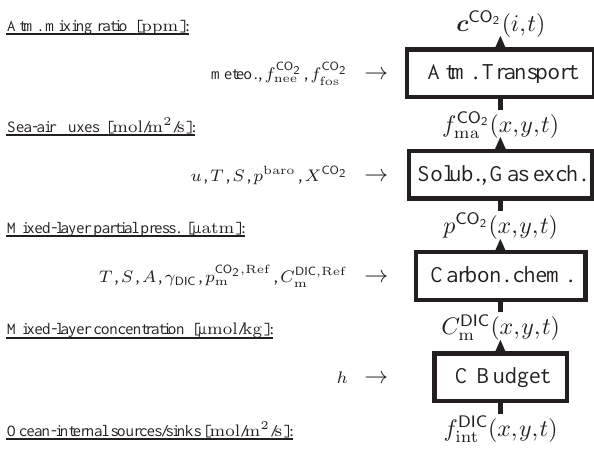
Fig. 1. Summary of the main quantities and process parameteriza- tions involved in the diagnostic ocean mixed-layer model. Thick boxes denote the process parameterizations given in Sect. 2.2, each expressing the quantity right above as a function of the quantity right below. Quantities at the arrows on the left represent driver data entering the parameterizations. See Table 2 for mathematical symbols, and Appendix A1 for the equations and further explanation.